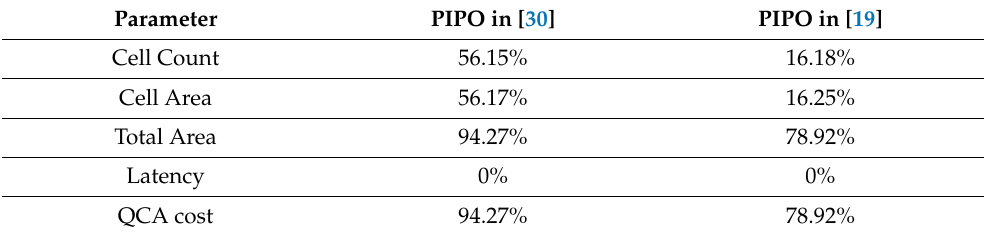
Table 9. Performance improvement of proposed 4-bit PIPO shift